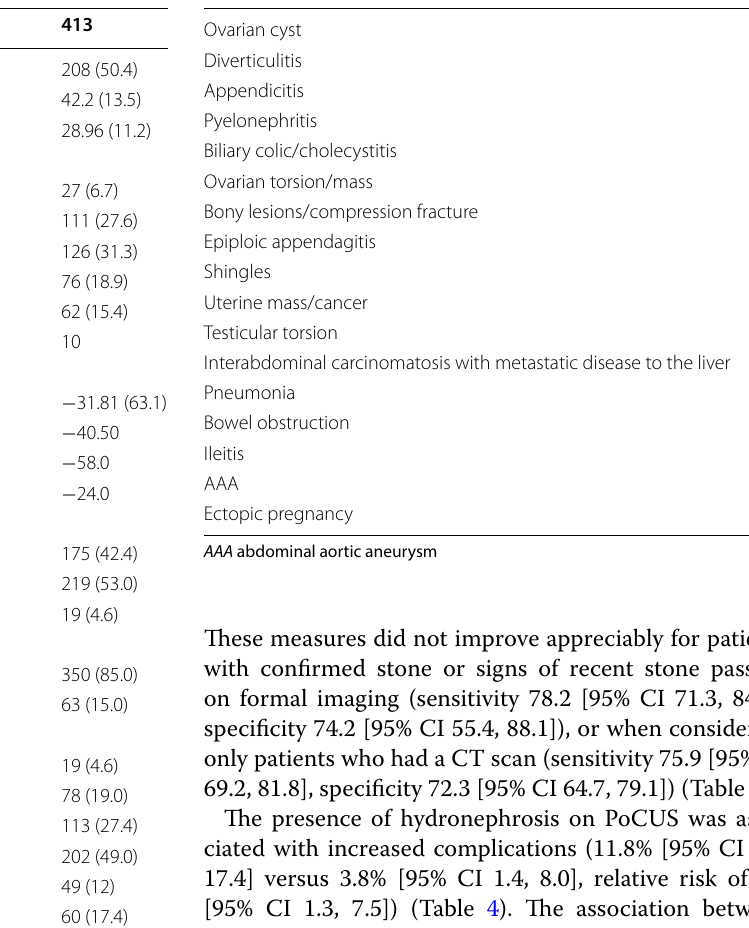
Table 1 Cohort characteristics Table 2 Alternative diagnoses found on formal